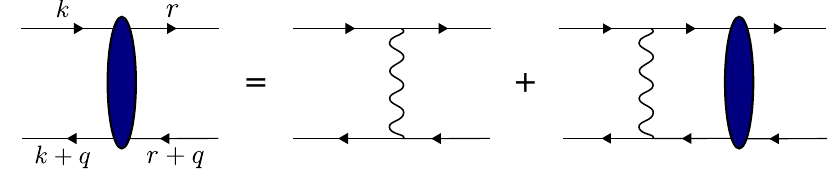
Figure 1 . Diagrammatic representation of the Schwinger-Dyson equation defining the kernel Γ, denoted as a blue blob, that resums ladder diagrams. Lines denote exact fermion propagators and wavy line gluon ones. The external momenta k and r are arbitrary while q points in the